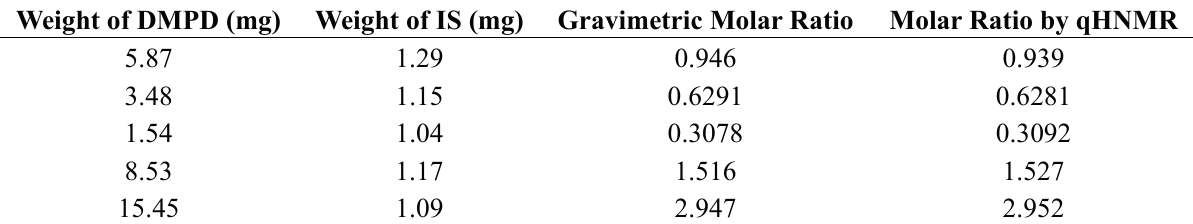
Table 2. Preparation of linearity samples and linearity